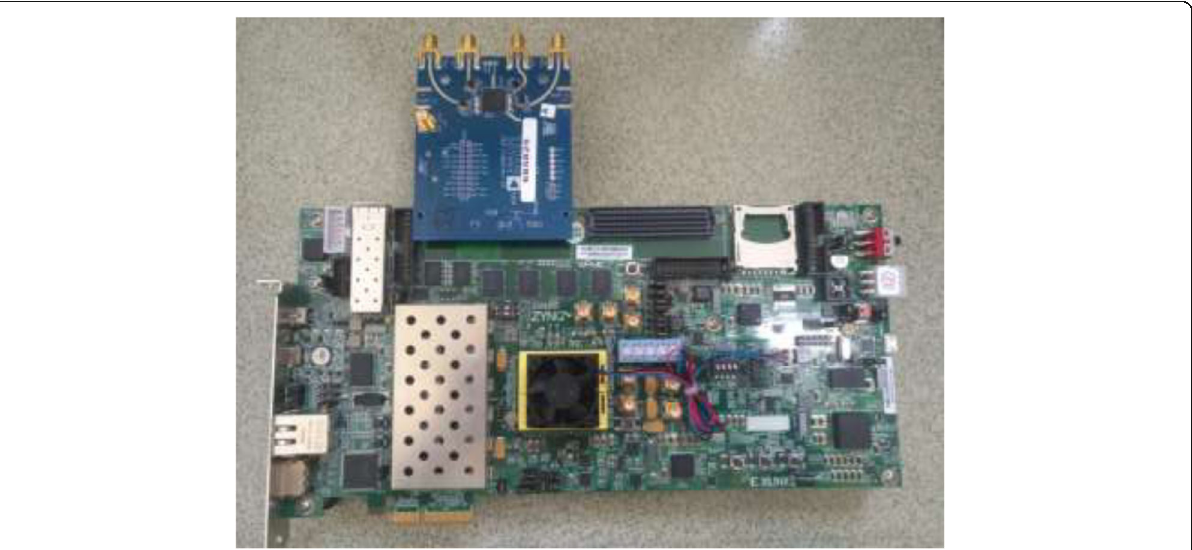
Fig. 15 The physical connection between AD9361 and ZC706. The AD9361 board card and the ZYNQ ZC706 development board are connected by